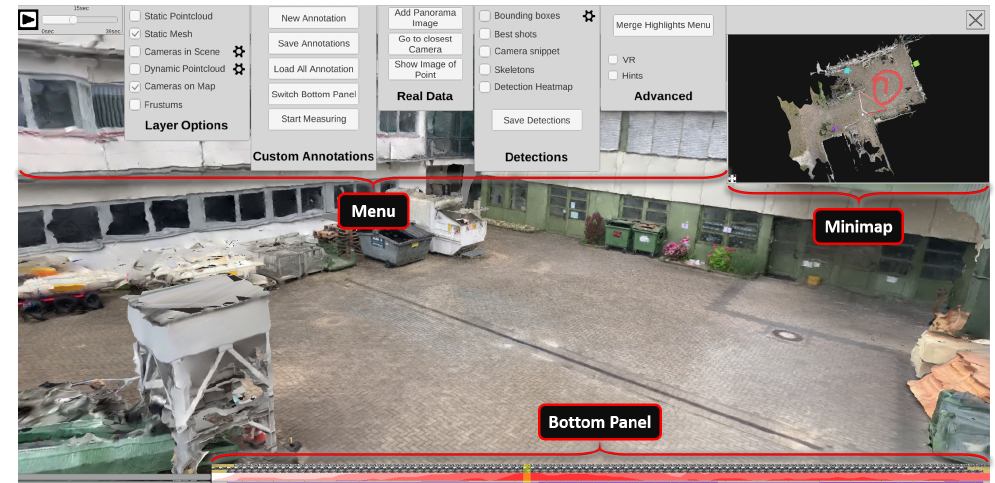
Figure 13. The graphical user interface of the presented demonstrator consists of four main parts: a menu at the top, a minimap at the top right, a bottom panel, and the main window as a view of the inspected scene.